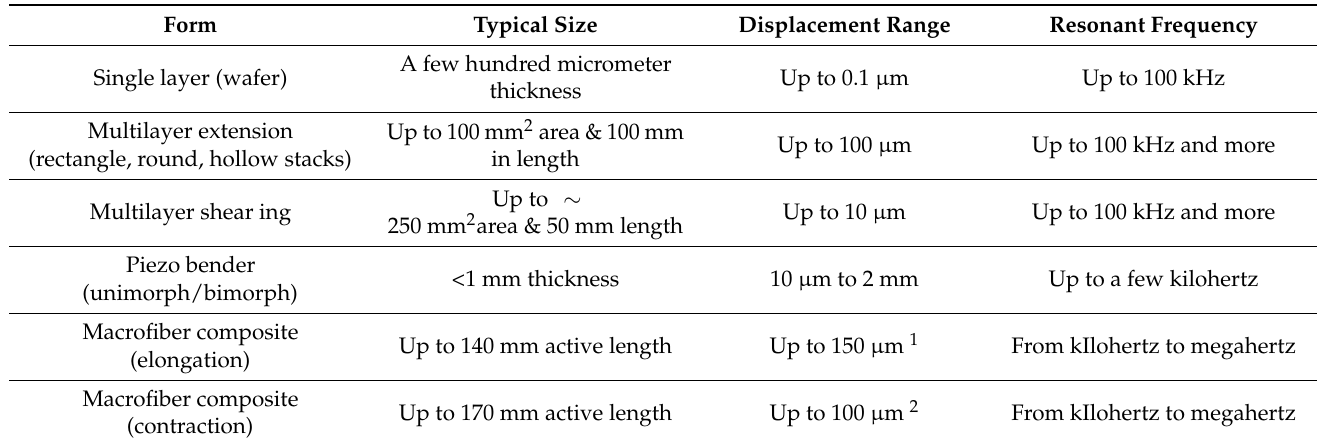
Table 2. Typical displacement and resonant frequency of typical geometrical forms of commercial piezoelectric